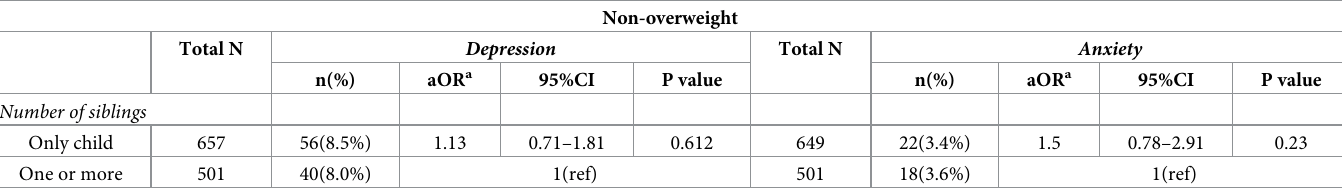
Table 4. Adjusted odd ratios of anxiety and depression at follow-up for the number of siblings in non-overweight